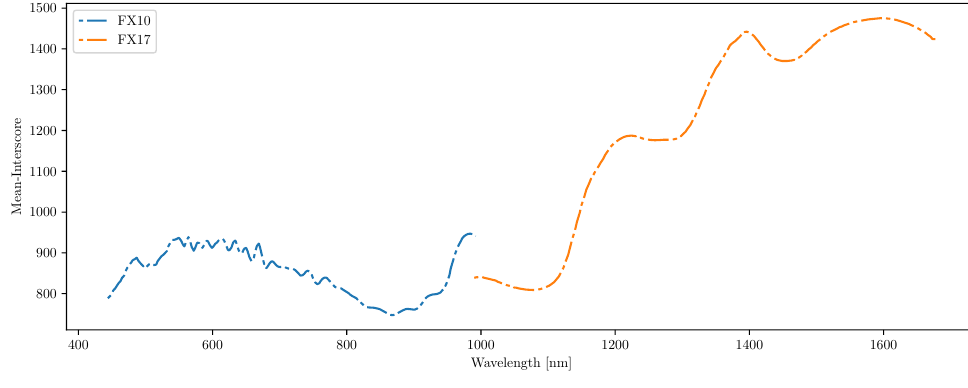
Figure 6. Mean interscores for all captured spectral